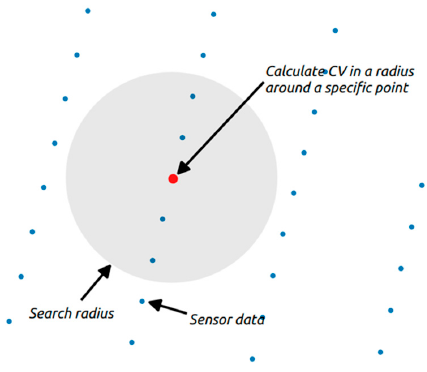
Figure 6. Inlier filtering process.